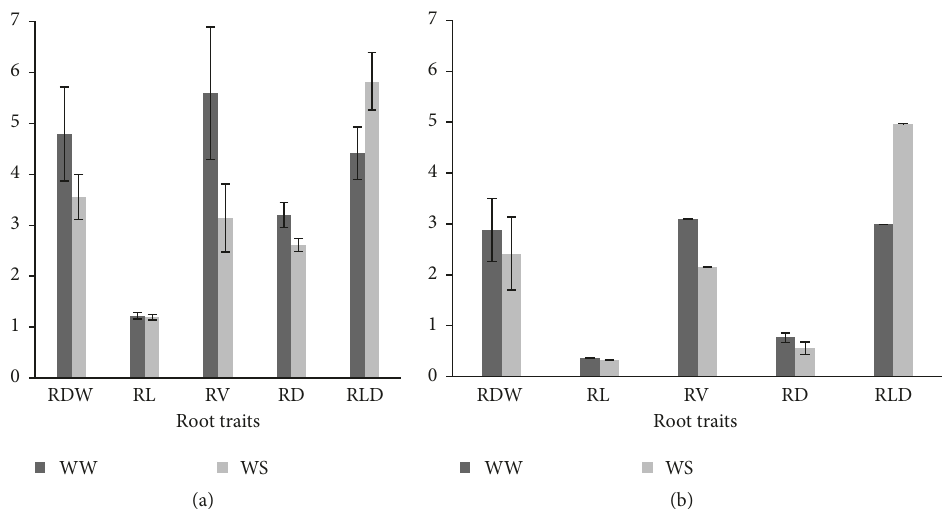
Figure 3: Root dry weight (RDW), root length (RL), root volume (RV), root diameter (RD), and root length density (RLD) of groundnut genotypes under well water (WW) and water stress (WS) in lysimeter (a) and pot (b) experiments. Values are in 10 2 for RL, 10 1 for RV, and 10 2 for RLD.